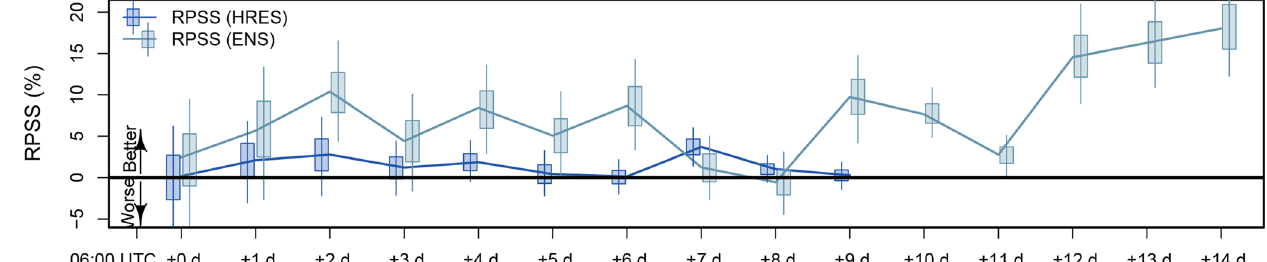
Figure B1. RPSS comparison between boosting trees and ordered logistic regression for lead times from + 0 to + 14d. For the boosting trees based on HRES NWP model output, the OLR based on HRES output is used as reference (boosting trees based on ENS output have OLR based on ENS output as reference). Higher RPSS shows better performance of the boosting trees over OLR. For forecasts with lead times longer than + 11d, the OLR is outperformed by climatology, whereas boosting trees still perform somewhat better than climatology. Thus, the boosting trees have high benefit over OLR at lead times longer than + 11d. The lines show the median RPSS, the boxes the 25th to 75th percentiles, and the whiskers the 5th to 95th